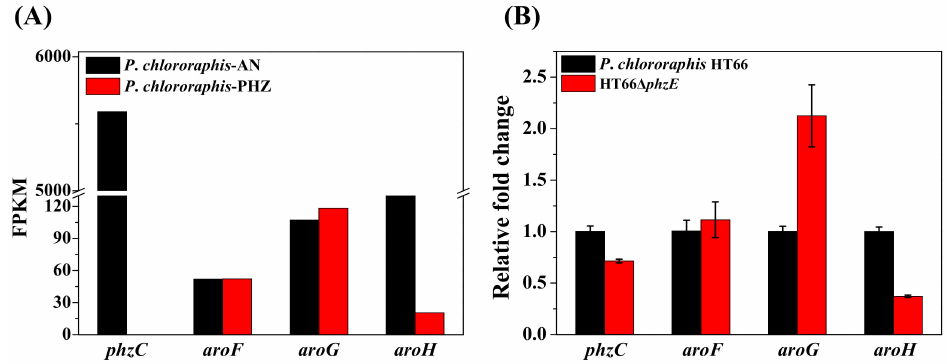
Figure 3. The expression differences of different DAHP synthase enzymes by transcriptome and relative quantitative PCR analysis. ( A ) Based on transcriptome analysis; ( B ) Based on relative quantitative PCR